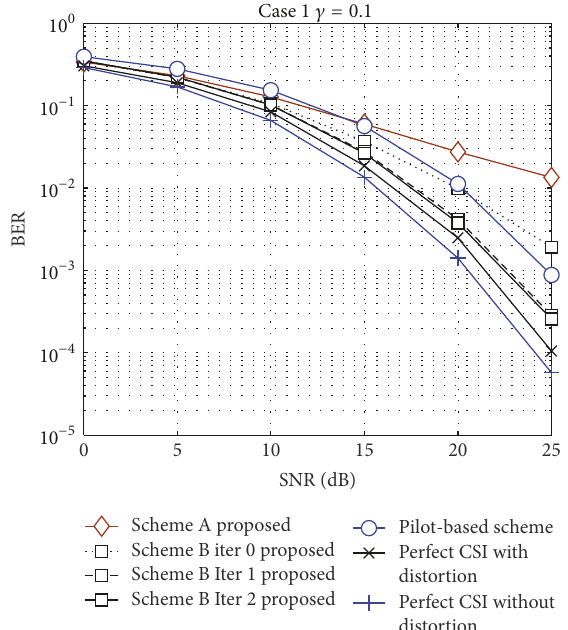
Figure 7: BER performance with different schemes for Case 1 .